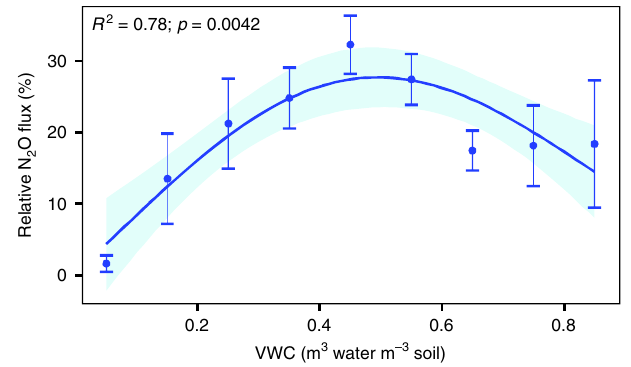
Fig. 5 Relative N 2 O fl uxes versus volumetric water content (VWC) in 11 published annual time series. The N 2 O fl uxes are scaled to the maximum value measured at each respective site. The dots and whiskers are average ± s.e.m. within the respective soil-moisture class. The curve is the GAM regression ( k = 3) between average relative N 2 O fl uxes and VWC. The light blue area marks the 95% con fi dence limits of the